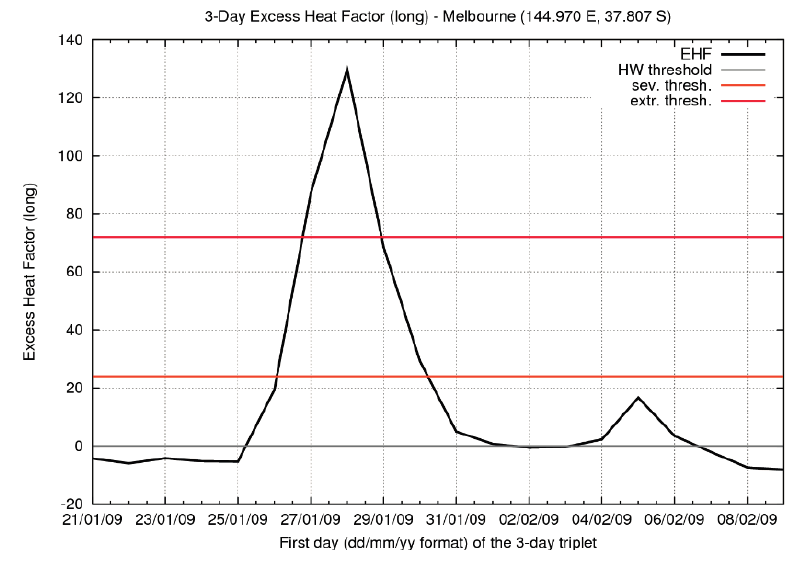
= 24.1 °C, with the severity 95